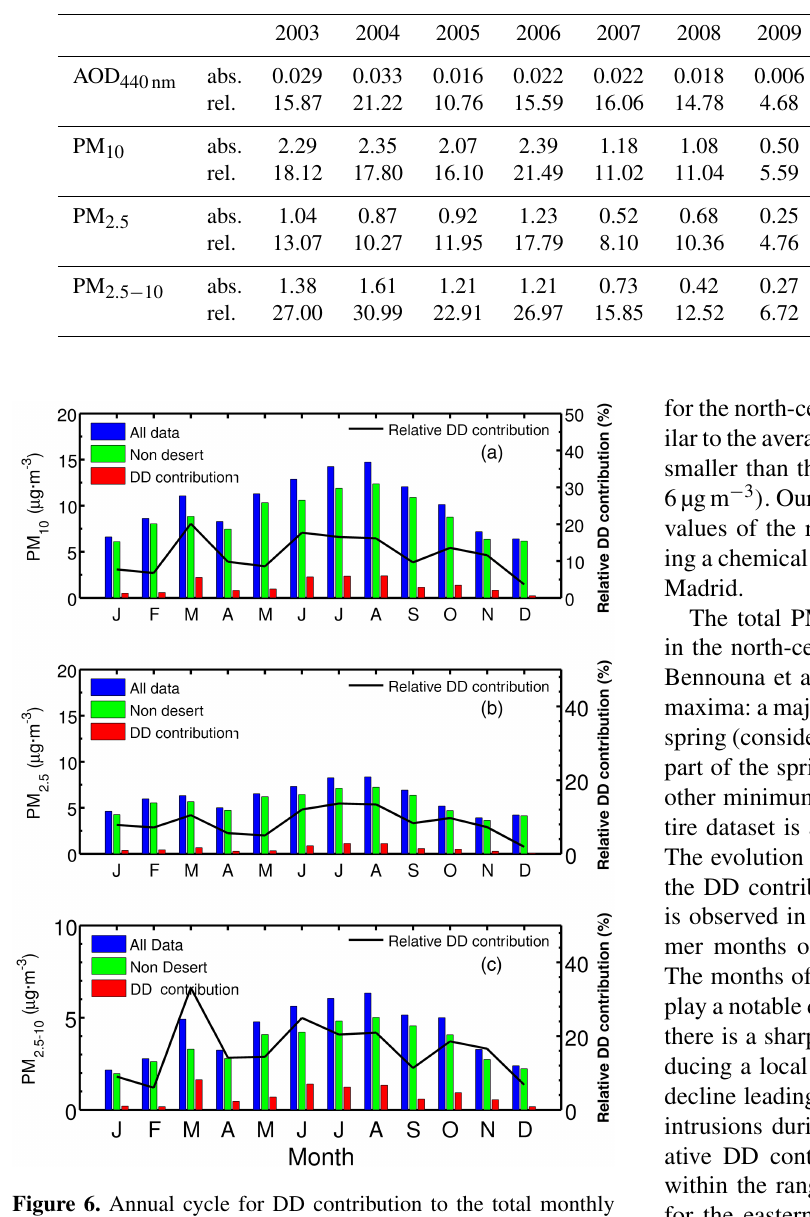
Table 5. Mean annual contribution of DD to total AOD and PM x in absolute (“abs.”, AOD units, and µgm − 3 , respectively) and relative (“rel.”, %) values during the 2003–2013 period.